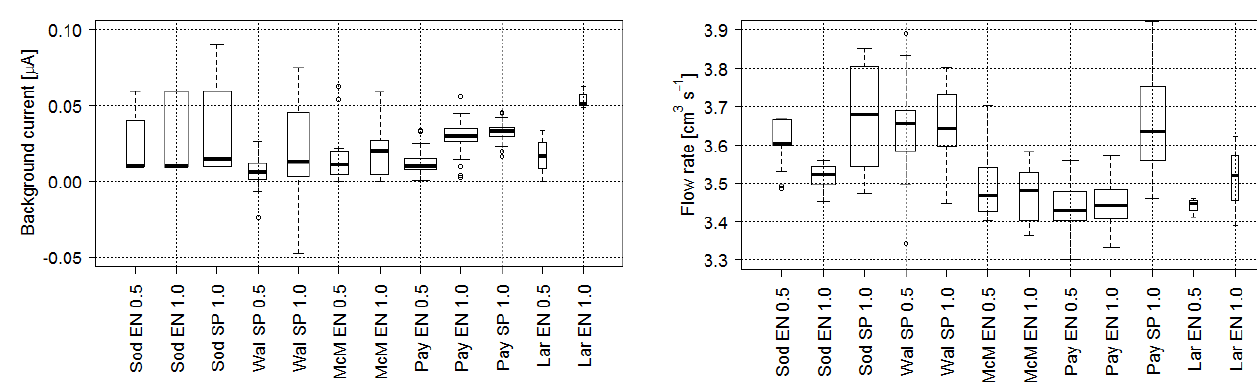
Figure 1. Boxplot of the background current (µA) measured at the five stations which flew a number of dual- or multi-ozonesonde gon- dolas: Sodankylä (Sod), Wallops Island (WaI), McMurdo Station (McM), Payerne (Pay), and Laramie (Lar). Following the station location, the ozonesonde manufacturer (EN or SP) and then the KI solution concentration (0.5 or 1.0%) are identified. Medians are the thick black segments, the interquartile range is the box height, 1.5 times the interquantile range are the whiskers, outliers are denoted as circles, and the square root of the number of measurements is re- flected in the box width. A value of 0.03µA corresponds to 0.1mPa of ozone.